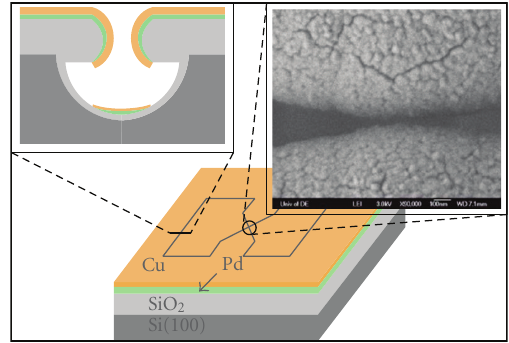
Figure 2: Schematic view of the device fabricated by ALD. The black region surrounding the device provides electrical isolation. A cross-sectional view is shown in the left inset. The right inset shows a scanning electron microscope image of the Pd seeded electrodes before Cu ALD [13].